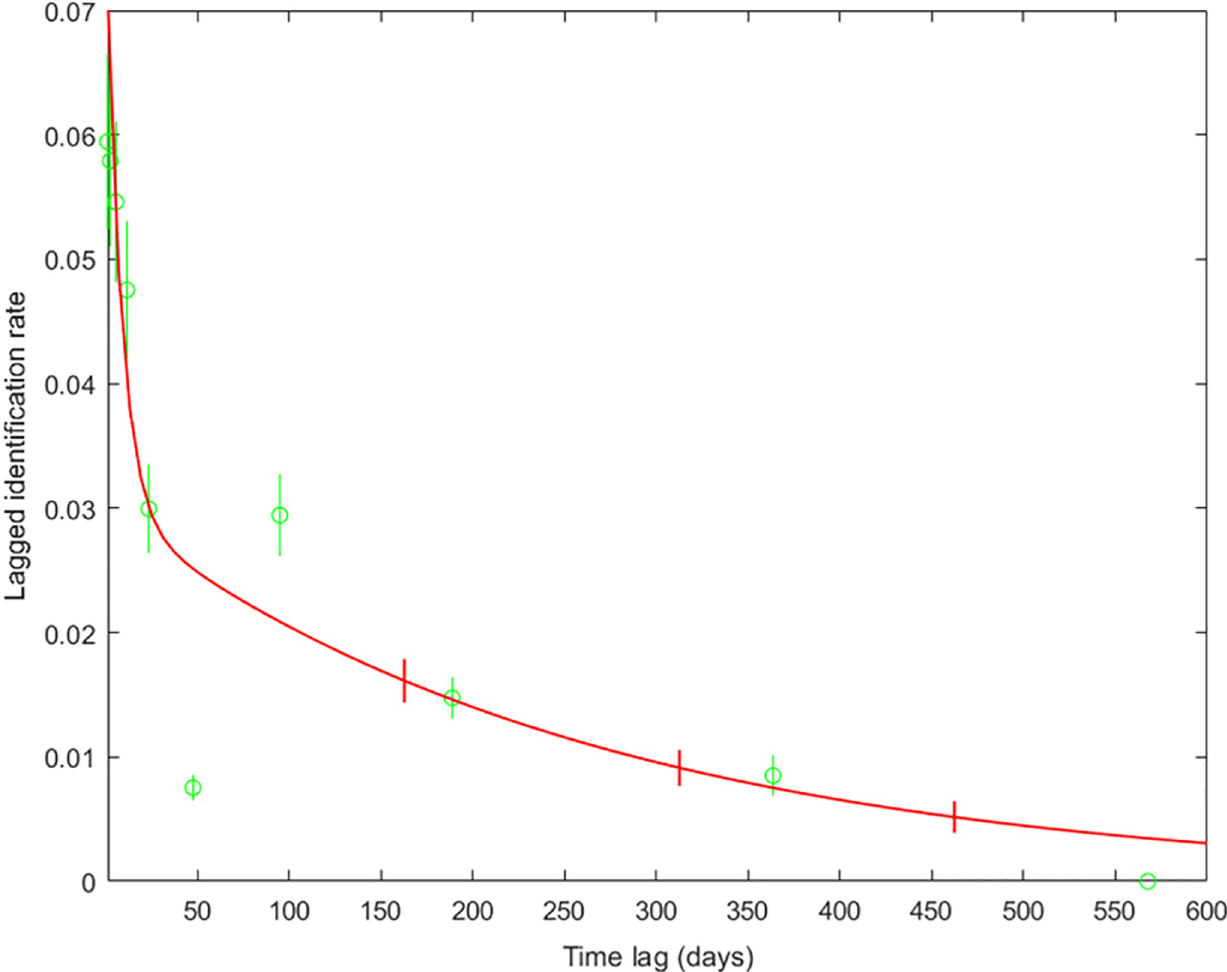
Fig 4. The probability that a fox identified on a given day would be the same as a randomly chosen individual at a later time (lagged identification rate, LIR) across the whole study (green circles) and the best-fitting model (red line). Error bars show bootstrap standard errors calculated over 100 replicates.